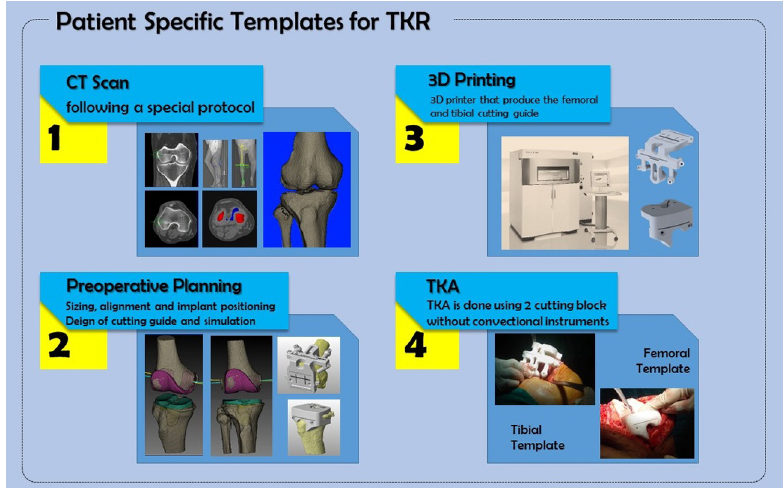
Figure 1. Hospital-based system for